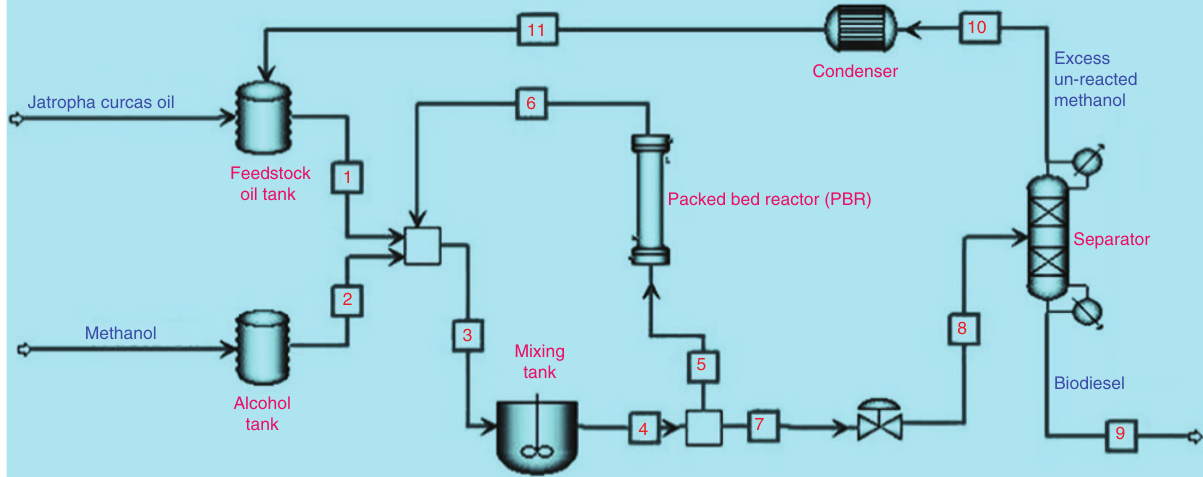
Figure 2: Schematic diagram of the process system for biodiesel